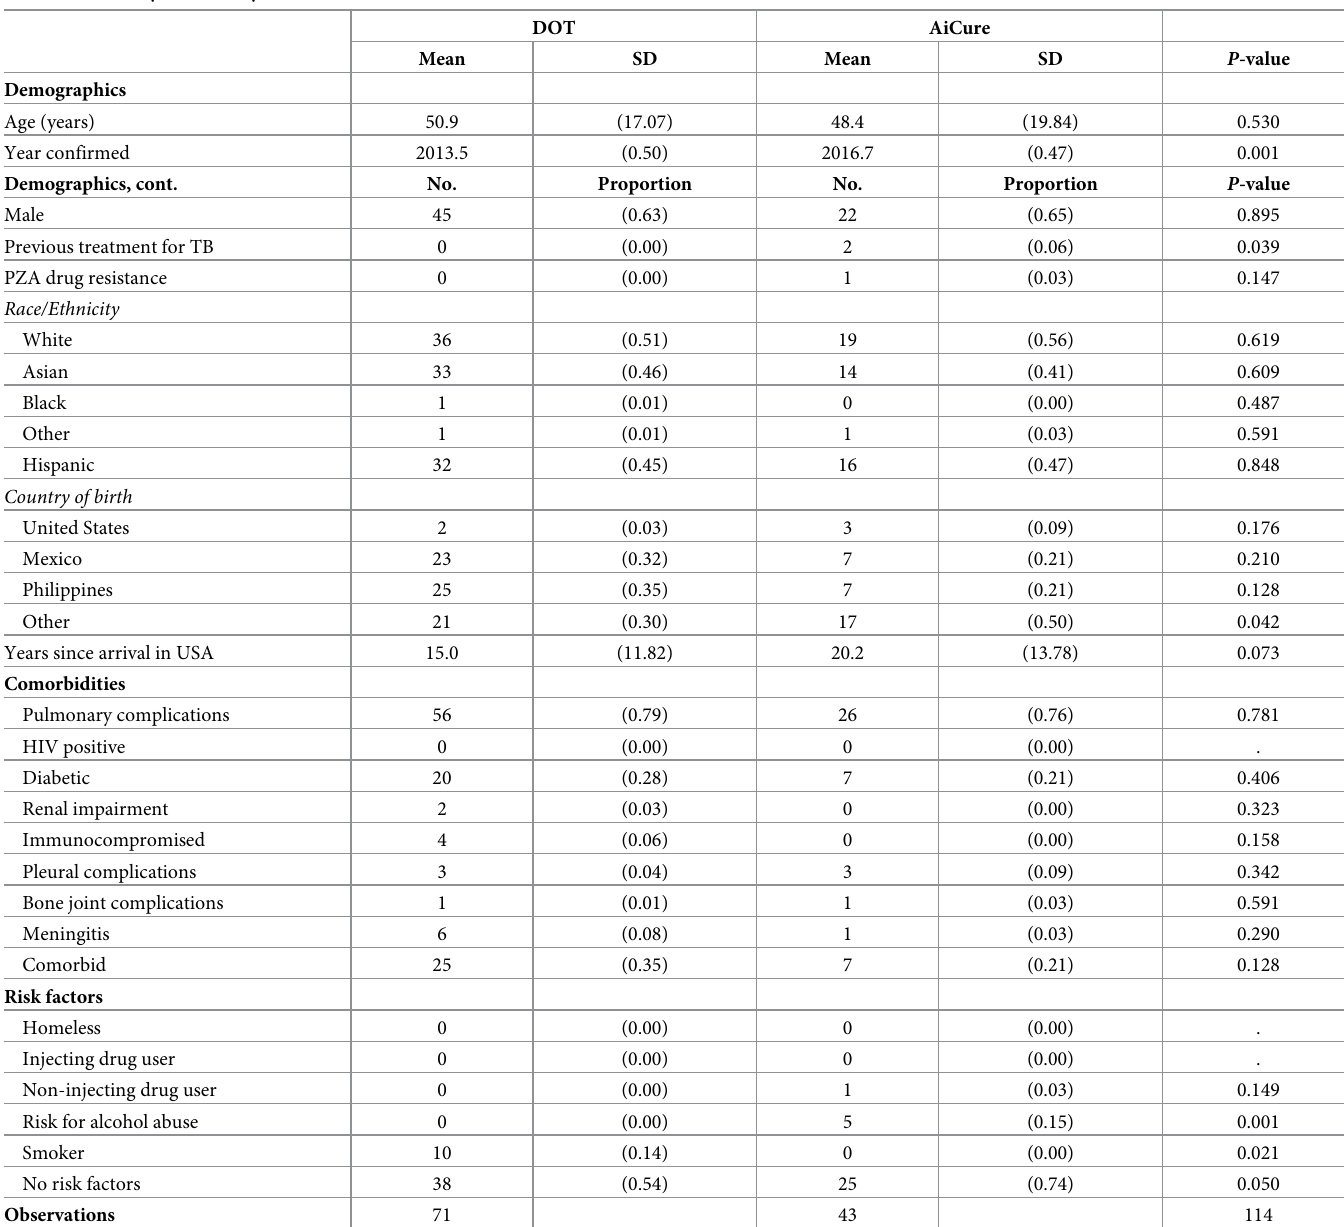
Table 1. Summary statistics by treatment